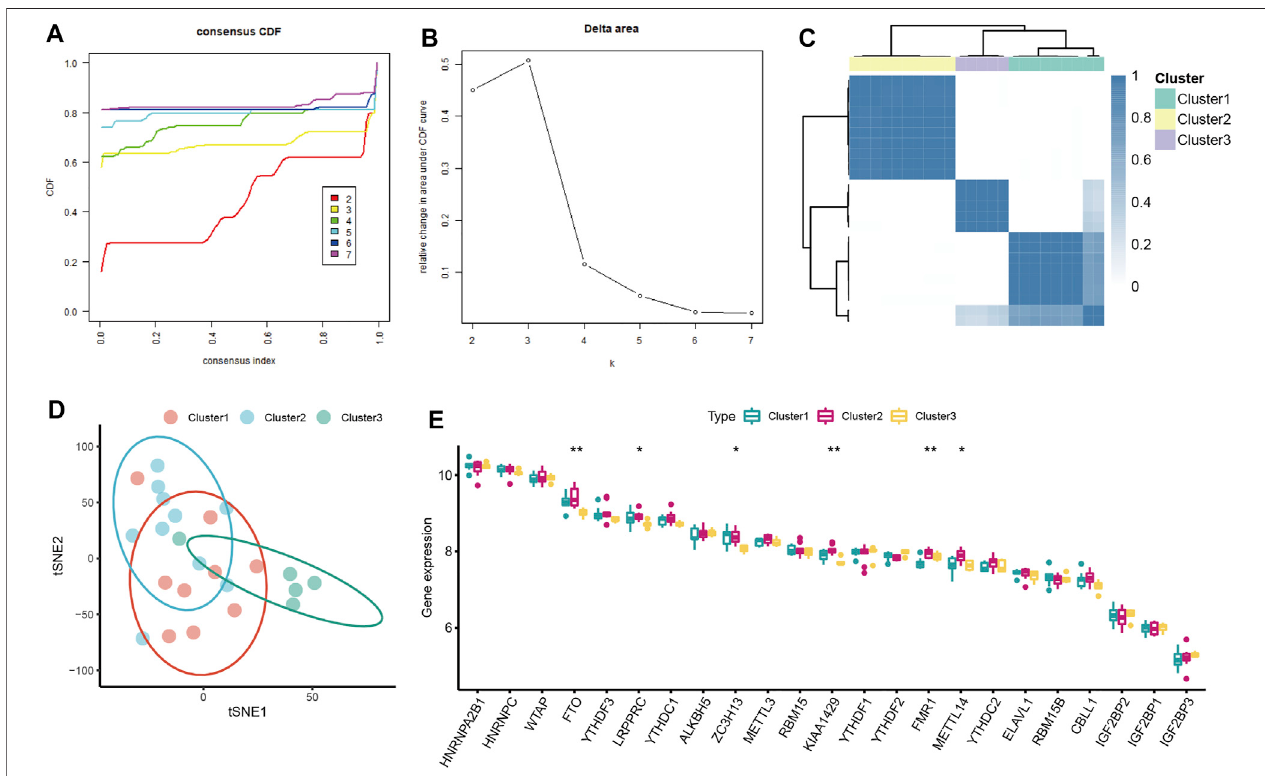
FIGURE 4 | Consensus clustering analysis of severe OSA subjects based on mRNA levels of OSA-related m6A regulators. (A) Consensus clustering cumulative distribution function (CDF) for k = 2 – 7. (B) Relative change in area under CDF curve fork = 2 – 7. (C) OSA subjects were divided into three clusters when k = 3. (D) The tSNE plot of the transcriptome pro fi les of 3 m6A subtypes. (E) The different expression status of 23 m6A regulators among three m6A